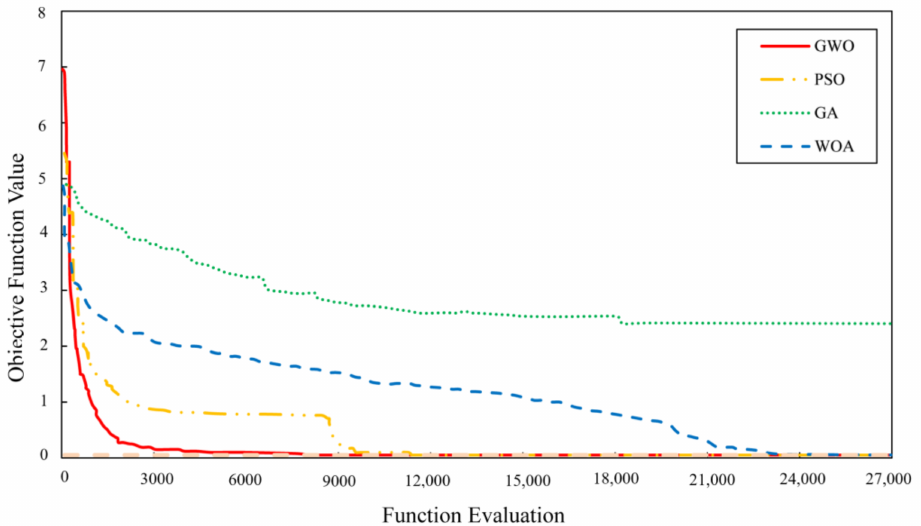
Figure 10. The algorithms’ convergent curves reaching the minimum defined objective function for GWO, WOA, PSO, and GA.